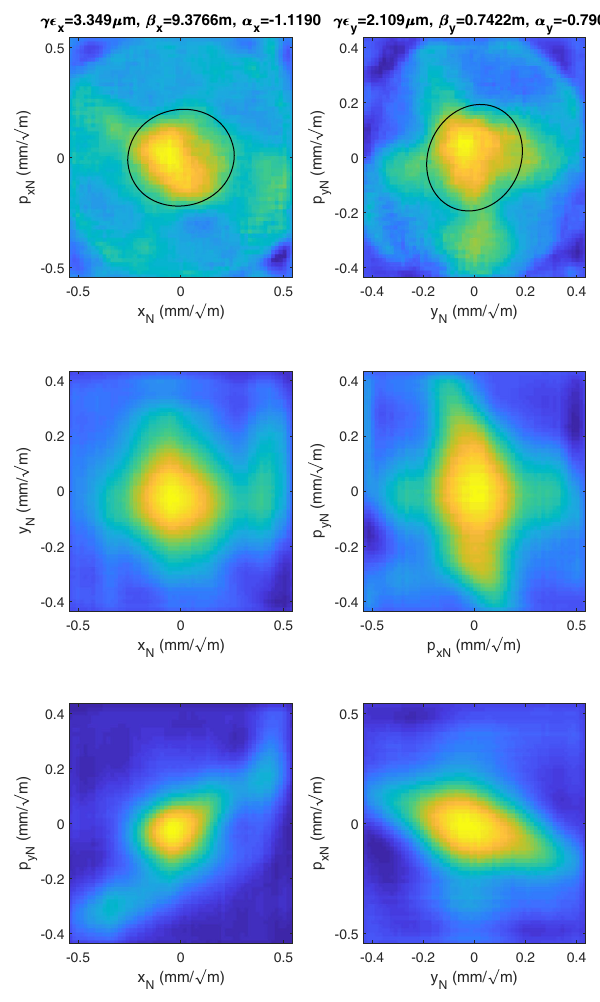
FIG. 37. Results from phase space tomography in two d.o.f. in the CLARA FE. Each plot shows a different projection of the charge density in four-dimensional phase space, using normal- ized phase space variables. Coupling in the beam is evident in the tilt of the charge distribution in the cases that the axes refer to different d.o.f. The black ellipses shown in the horizontal and vertical phase spaces show the rms of a Gaussian distribution fitted to the projections of the four-dimensional distribution onto these phase spaces: The emittances and Courant-Snyder param- eters (neglecting coupling) can be estimated from the sizes and shapes of these